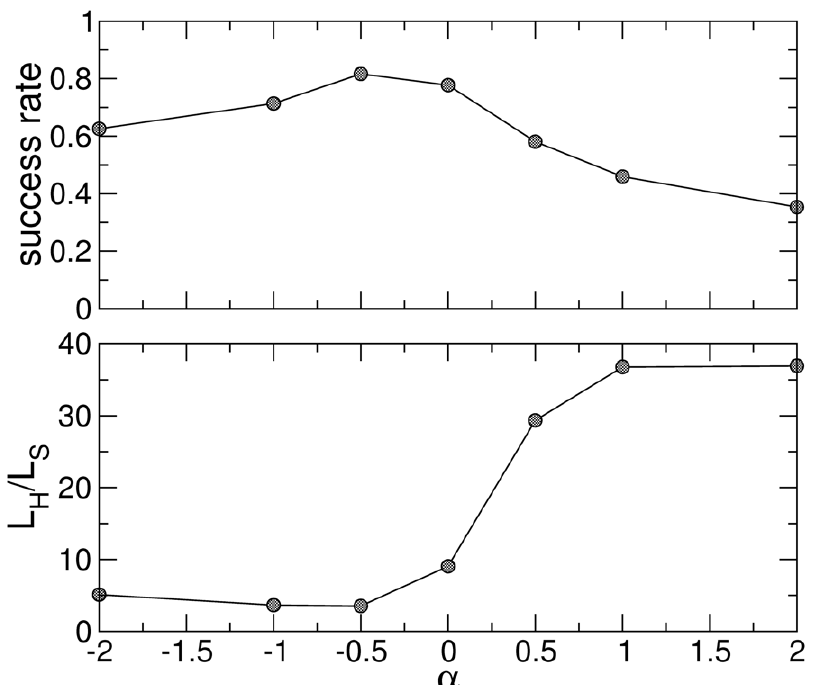
Figure 1. Success ratio (upper pannel) and length ratio (lower panel) of semantic paths reaching the destination as a function of the weighting scheme a .